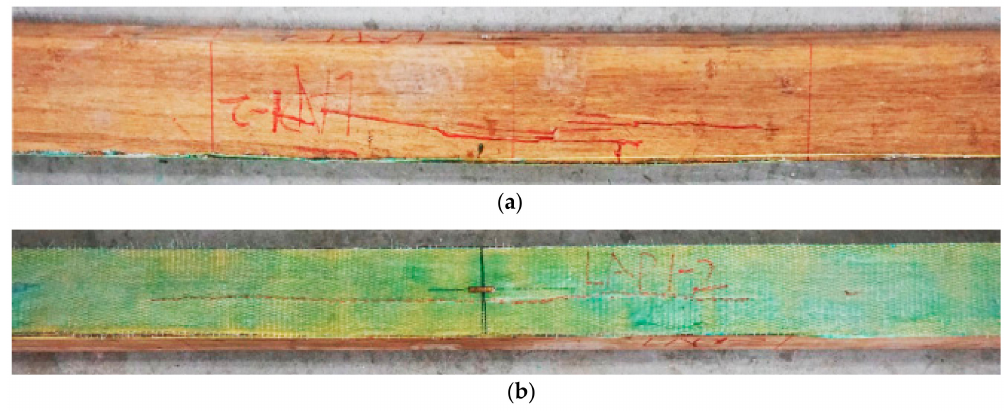
Figure 5. This is the typical failure photos for mode II (LAP1-2): ( a ) side surface; ( b ) bottom surface.